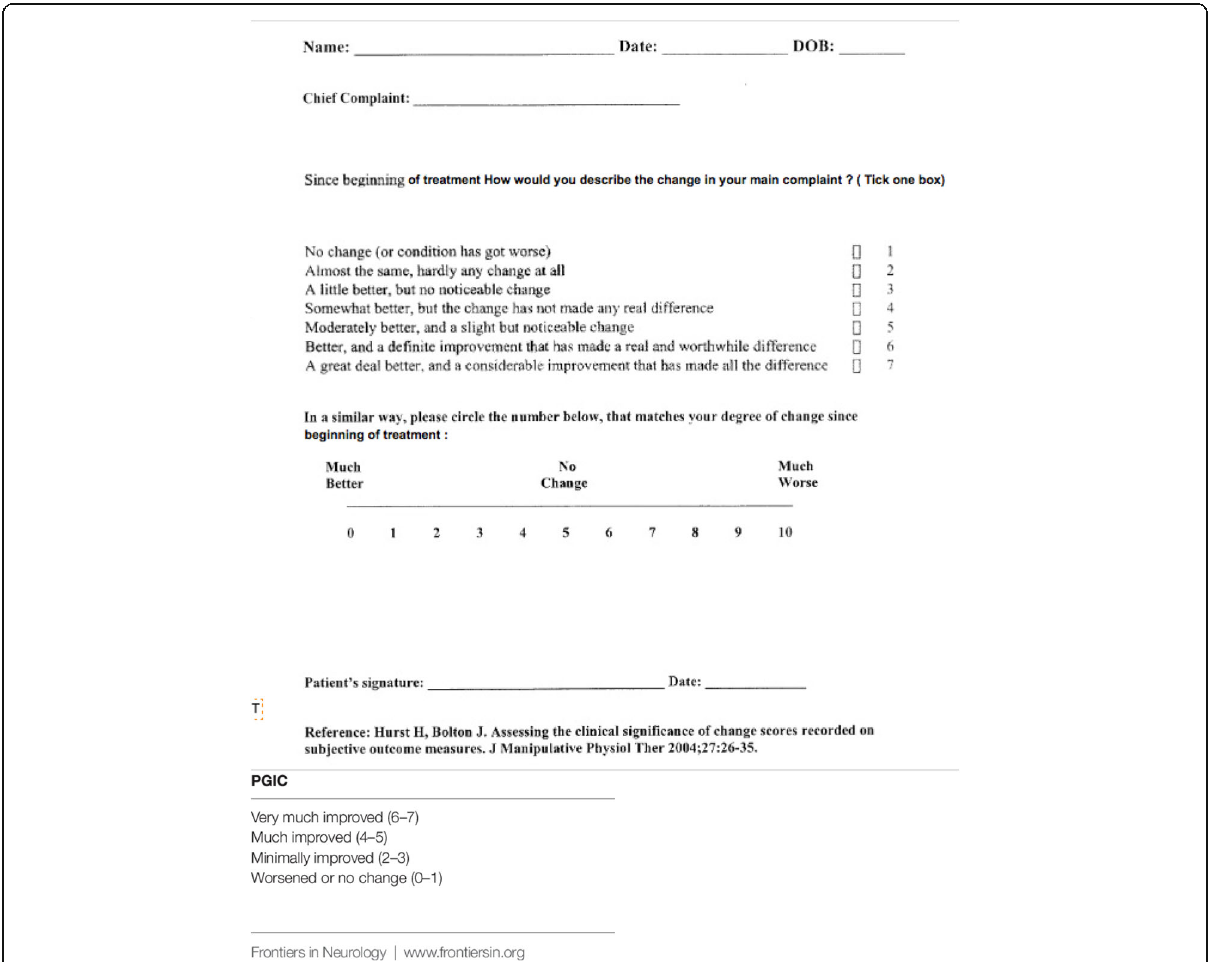
Fig. 1 PGIC questionnaire and the visual assessment